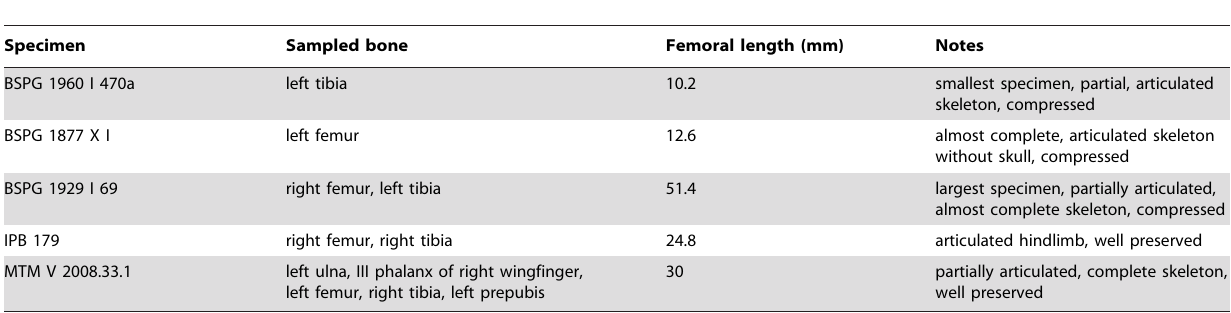
Table 1. Tabulation of specimens studied, selected elements, femoral length, and some particulars of specimens.